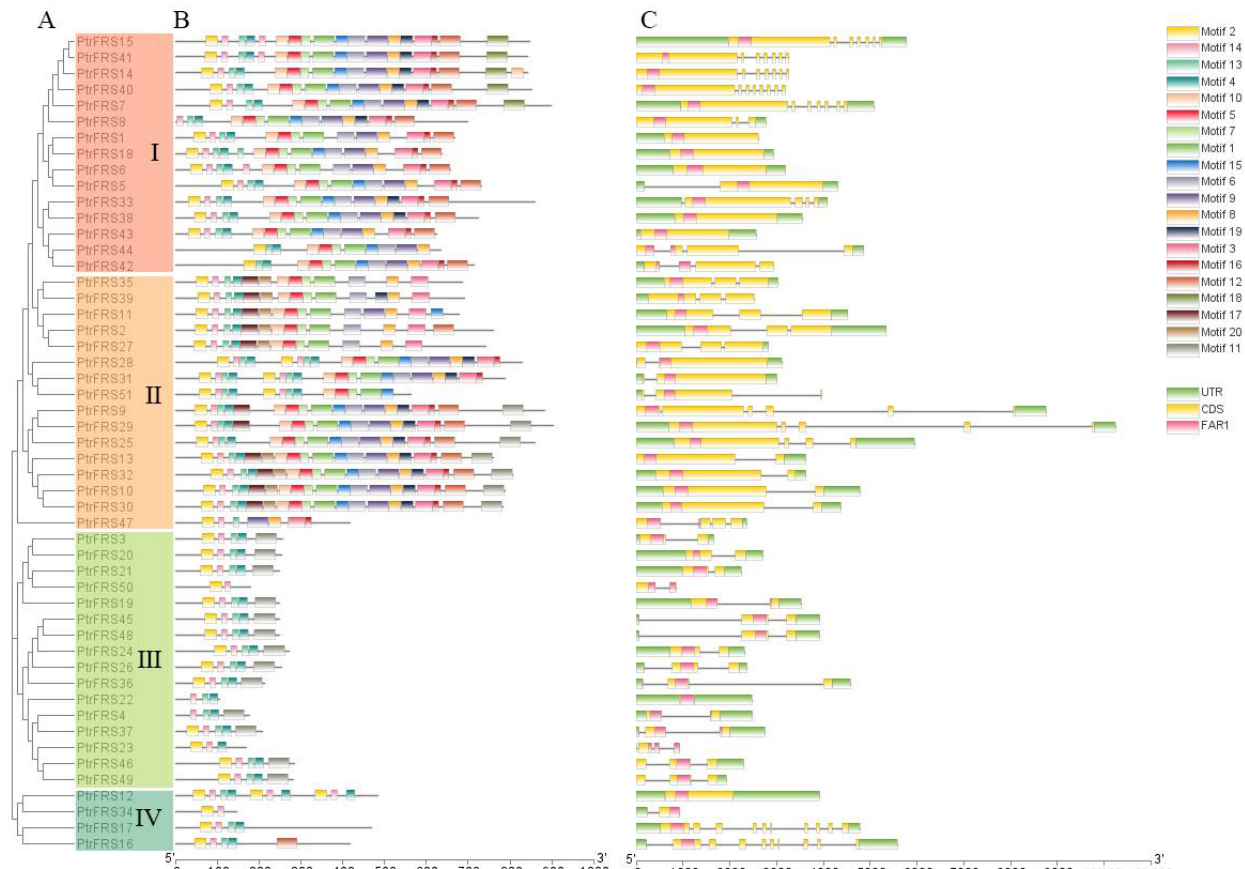
Figure 2. Phylogenetic and genetic structure analysis of PtrFRSs . ( A ) Phylogenetic tree constructed using the maximum likelihood method using 51 PtrFRS protein sequences and divided into four subfamilies. ( B ) Distribution of motifs in PtrFRS proteins, 20 motifs in total. ( C ) Structure of the PtrFRS genes, with the UTR in green, the FAR1 domain in pink, the exon in yellow, and the intron in the middle of the blank region.